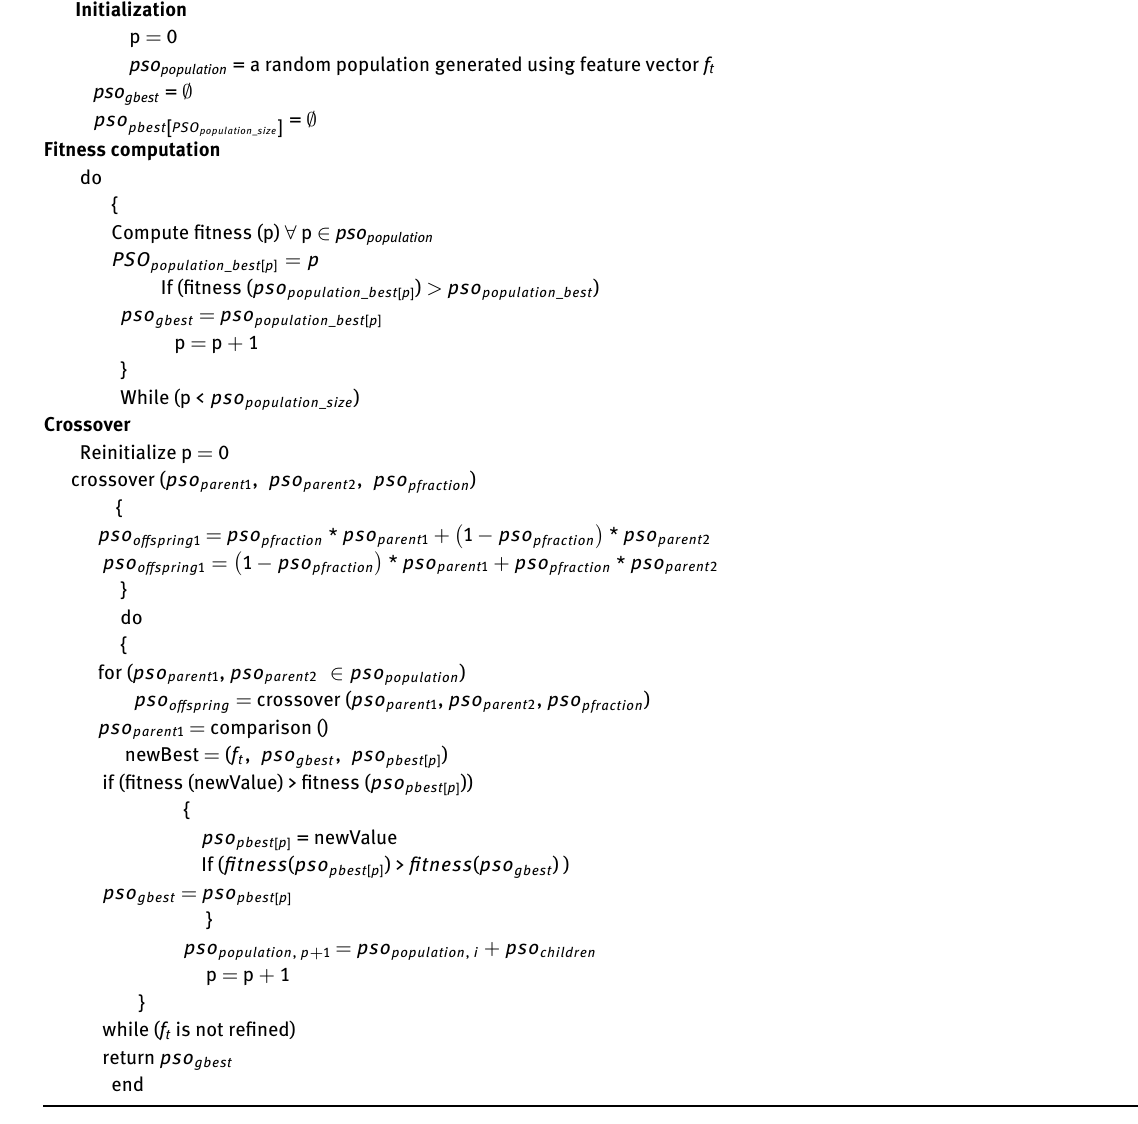
Algorithm 1: C-PSO ( pso population_size